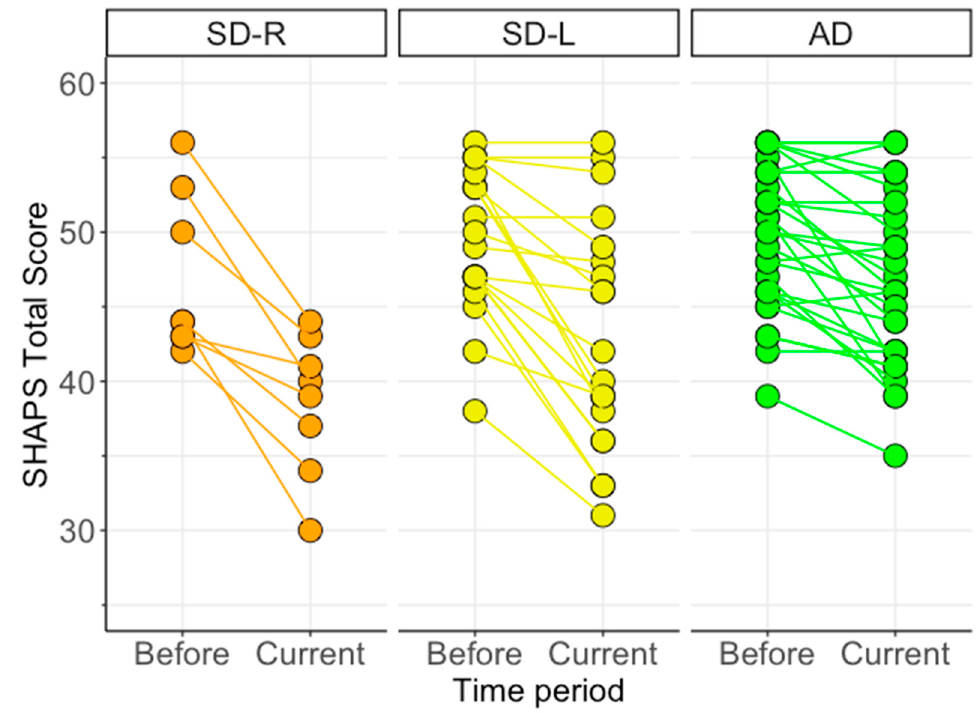
Figure 2. Change in anhedonia severity in dementia syndromes as rated by carers on the Snaith– Hamilton Pleasure Scale (SHAPS). Connecting lines reveal the magnitude of change between the patient’s level of anhedonia (i) pre-dementia onset (Before) and (ii) at time of assessment (Current). Maximum score on the SHAPS is 56, with lower scores reflecting greater levels of anhedonia. AD = Alzheimer’s disease ( n = 30); SD-L = left-predominant semantic dementia ( n = 20); SD-R = right- predominant semantic dementia ( n = 8).